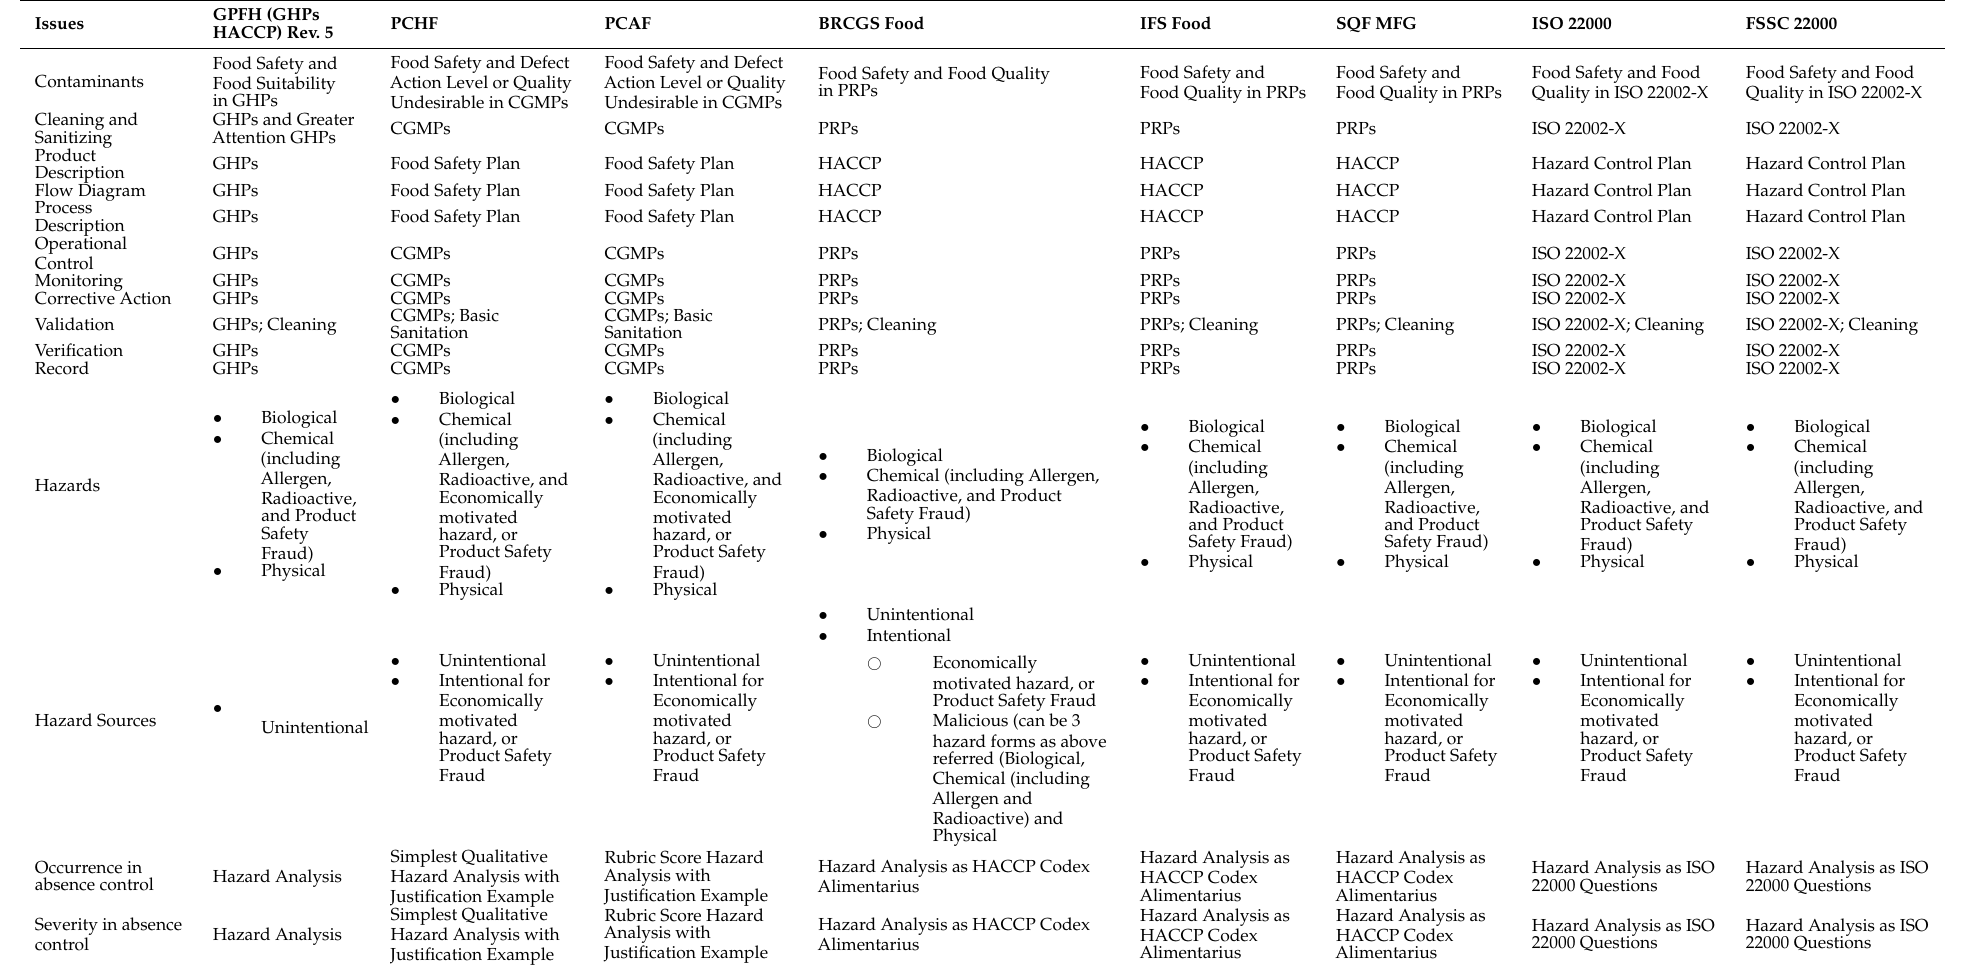
Table 1. Comparison of food risk assessment scheme in GHPs and HACCP, FSMA Preventive Controls for Human Food and Animal Food, ISO 22000, and GFSI Recognized